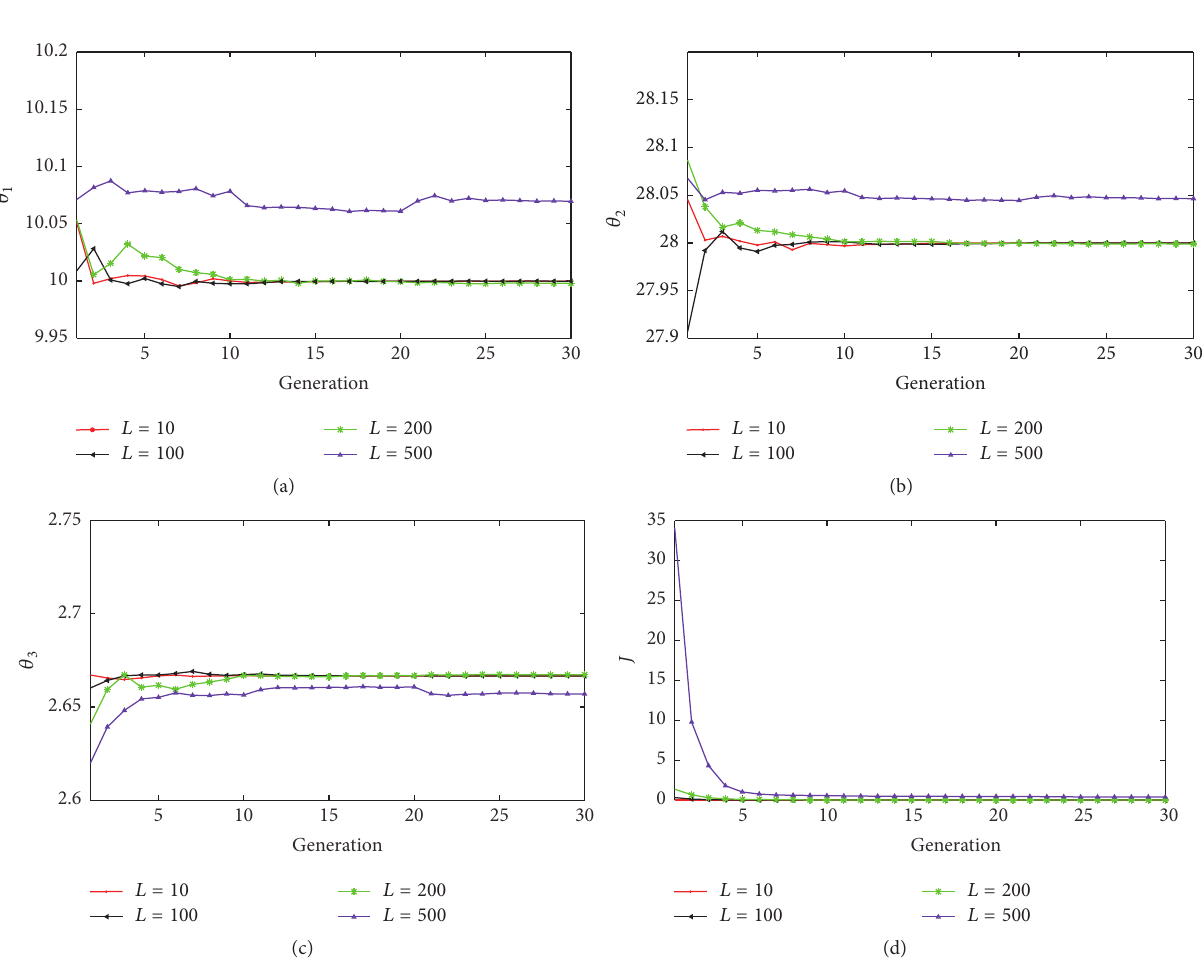
Figure 2: The evolving process of the average values for different time series L . (a) 𝜃 1 ; (b) 𝜃 2 ; (c) 𝜃 3 ; (d) 𝐽